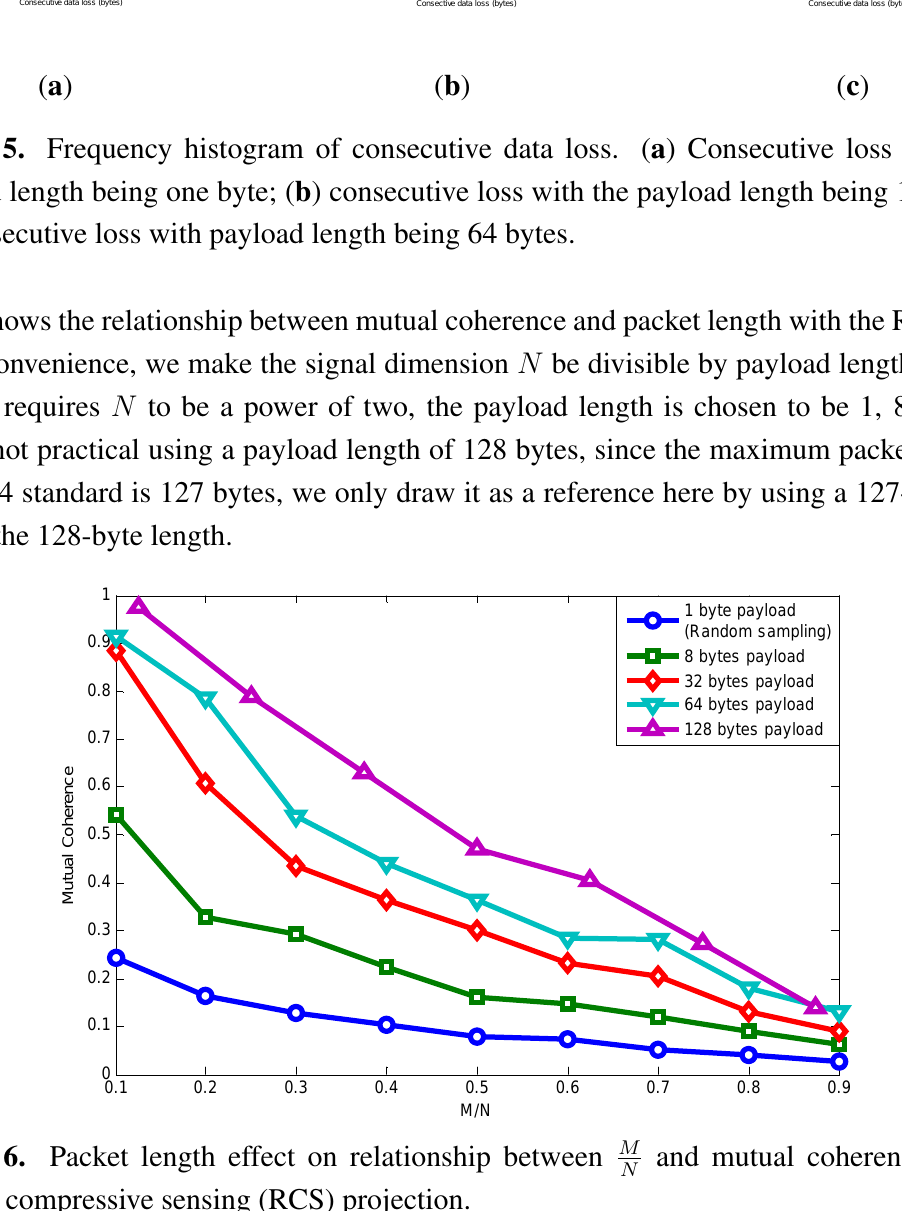
and mutual coherence using N